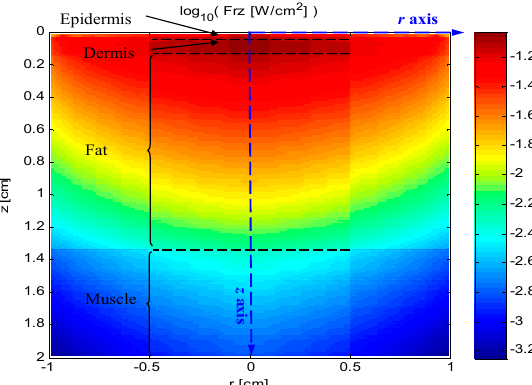
Figure 8. The longitudinal section of the energy distributions, of which horizontal axis represents r axis, and vertical axis represents z axis.